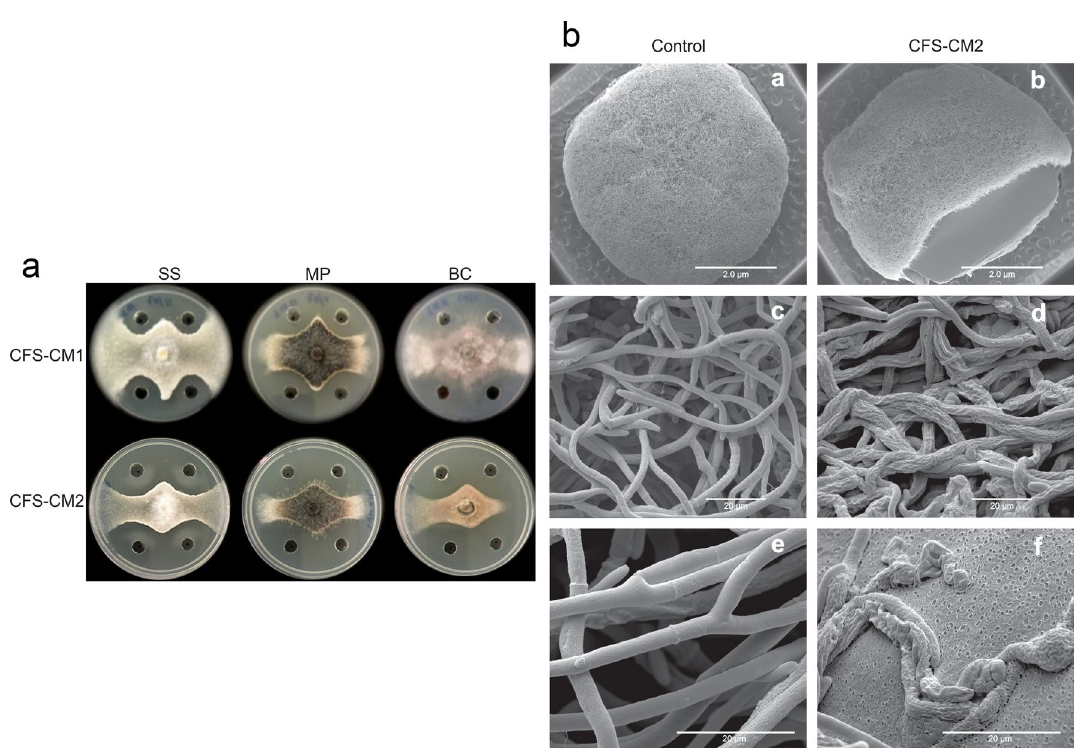
Figure 2. Antifungal effect of the cell-free supernatant (CFS) of Bacillus velezensis CMRP 4489. ( a ) Evaluation of antifungal activity against Sclerotinia sclerotiorum (SS), Macrophomina phaseolina (MP), and Botrytis cinerea (BC) by metabolites produced in CM1 and CM2 media. ( b ) Scanning electron microscopy images of the antifungal effect of the CFS against Sclerotinia sclerotiorum . The control refers to the untreated fungal spot and CFS-CM2 refers to the transition area between fungal growth and the inhibition